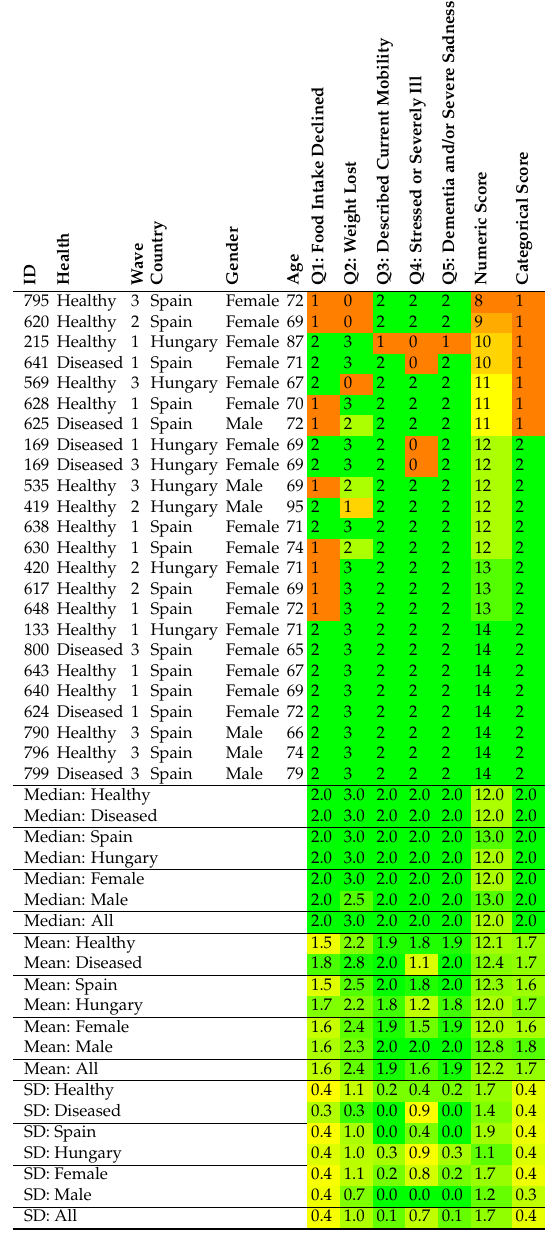
Table A7. Characteristics of PRO Nutrition (SelfMNA).